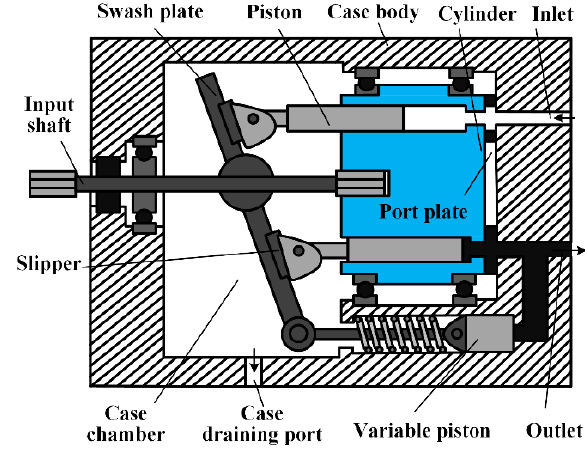
Figure 3. Structure and working mechanism of piston pump. There are many pairs of components with relative motion in the axial piston